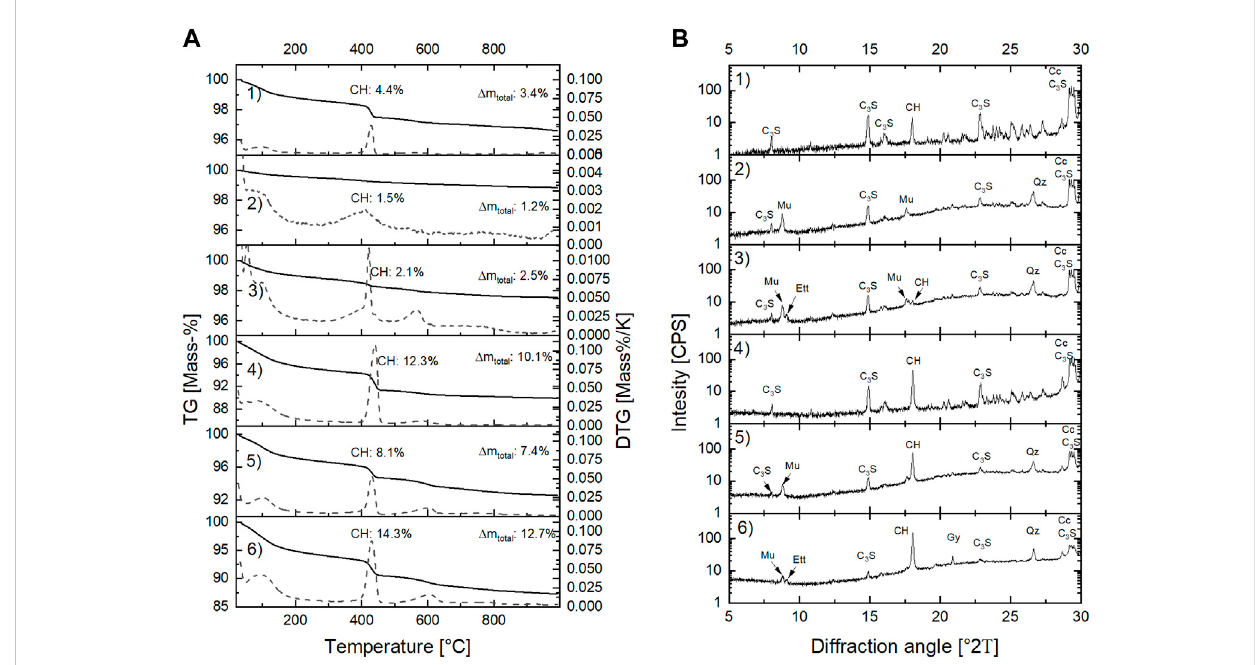
FIGURE 3 Results of TG (solid lines), DTG (dashed lines) (A) and XRD (B) analyzes of pastes hydrated with H 2 O or saturated gypsum solution for 7 h and 24 h. Abbreviations: CH (portlandite) Mu (muscovite), Ett (ettringite), CH (portlandite), Gy (gypsum), Qz (quartz), Cc